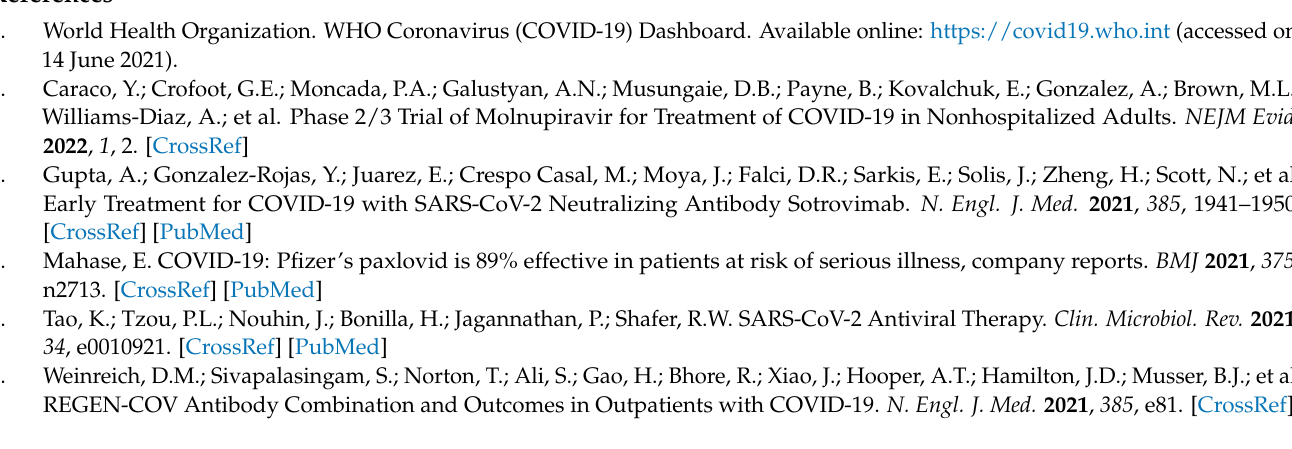
Figure S3: Inhibition of rab1B leads to redistribution of SARS-CoV-2 S in infected HEK293 ACE2 cells, Figure S4: Control Panels of single-expressed S and endogenous GM130 and ERGIC-53 in HuH7